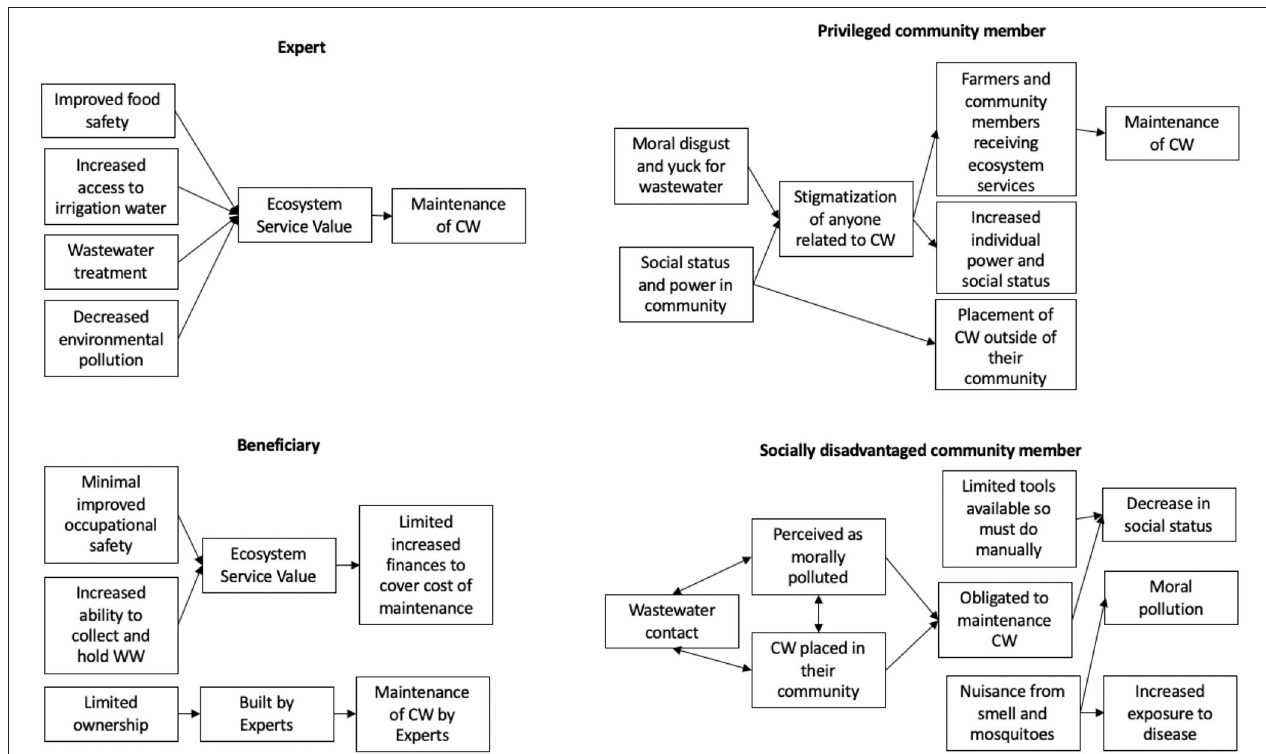
FIGURE 3 | Mental models of plural valuation of ecosystem services by